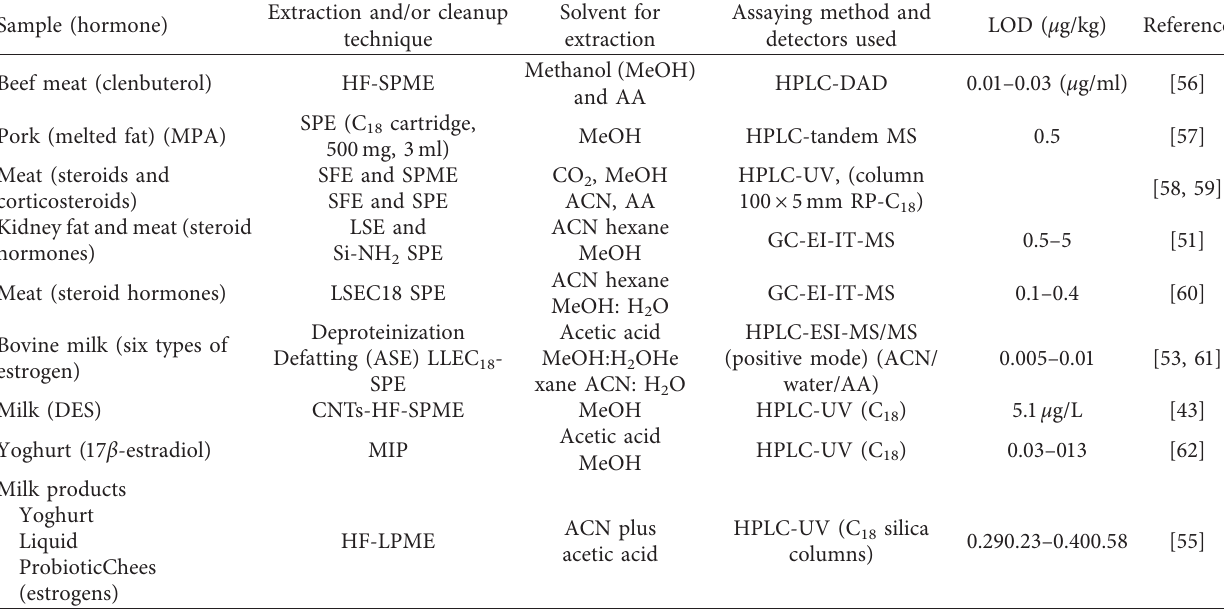
Table 3: Determination of hormones and hormonal anabolics in food of animal origin using different techniques of sample preparation and analytical